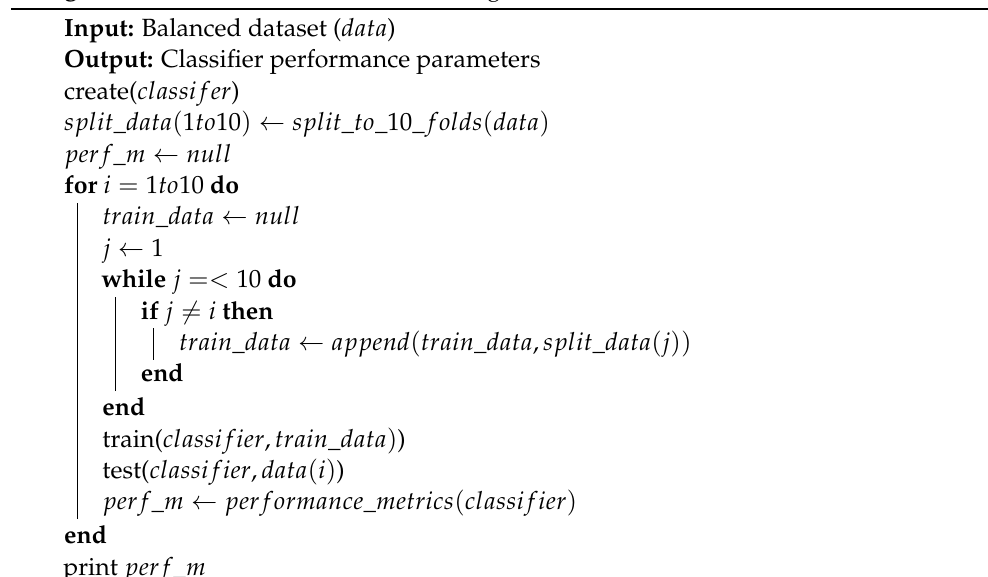
Algorithm 3: 10-fold Cross-Validation